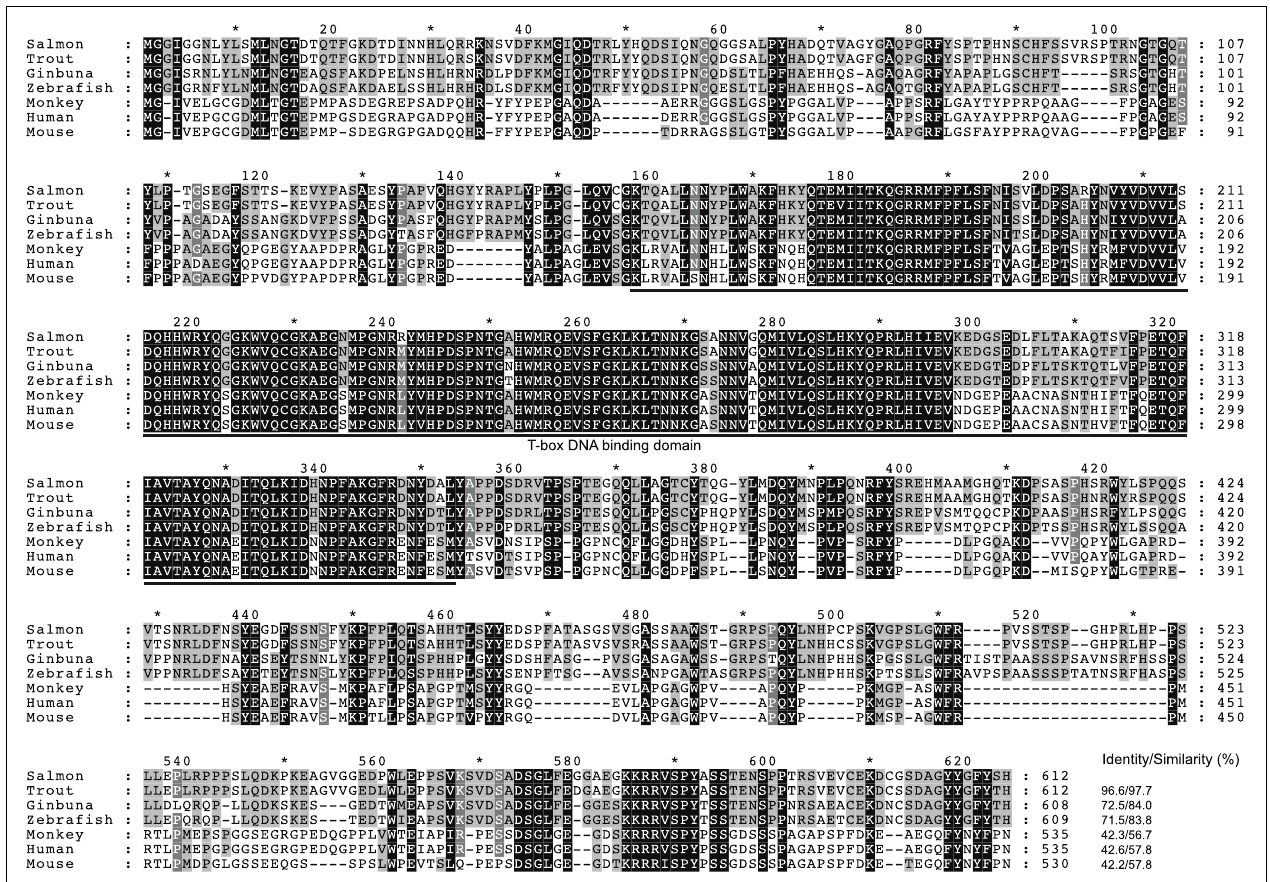
species aligned, and residues shaded in gray refer to 60–80% identity. Dashes indicate gaps. The T-box DNA binding domain is indicated by solid line below the alignment. Accession numbers are given in Figure 3